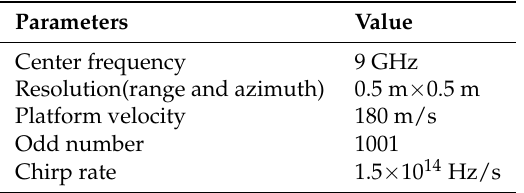
Table 2. Main parameters of the synthetic aperture radar (SAR) imaging scene.